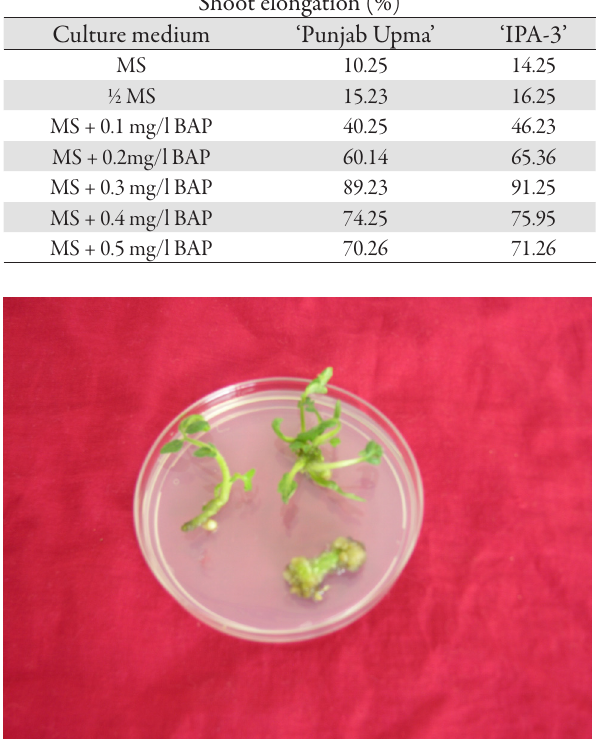
Fig. 2. Hypocotyl explants showing regeneration